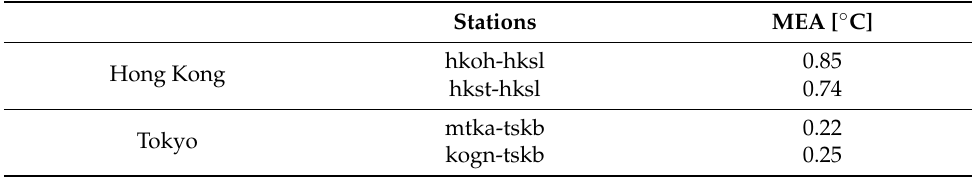
Table 4. Mean absolute